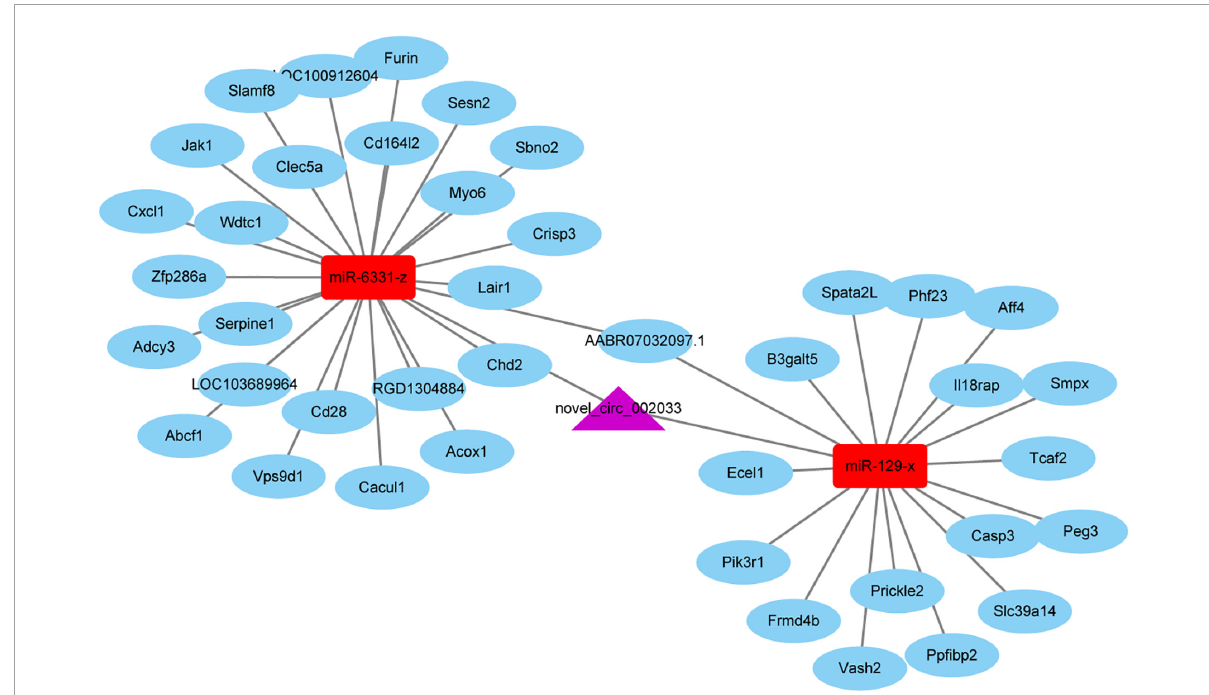
FIGURE7 The competing endogenous RNA (ceRNA) network of novel_circ_002033. Purple indicates circular RNA novel_circ_002033, red indicates microRNAs miR-6331-z and miR-129-x, and blue indicates target